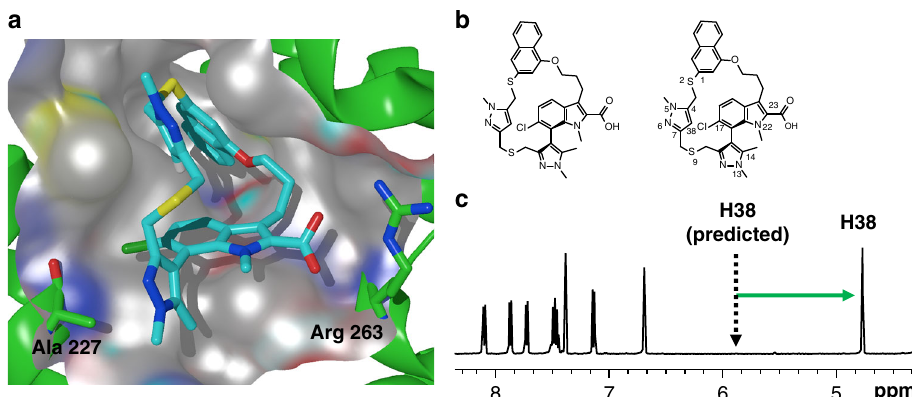
Fig. 2 Chemical and crystal structure of ( R a )- 7 . a Crystal structure of ( R a )- 7 in complex with Mcl-1. Note coplanar alignment of Arg 263 and the carboxylic acid and the interaction between 17-Cl of ( R a )- 7 and the backbone carbonyl of Ala227 ( PDB ID : 6FS0). The protein surface around the highlighted residues has been hidden for clarity. b Structure of ( R a )- 7 and numbering of atoms. c 1 H NMR of ( R a )- 7 , highlighting the up fi eld chemical shift of H38 indicative of a conformation that is rigid and consistent with the active binding conformation depicted in